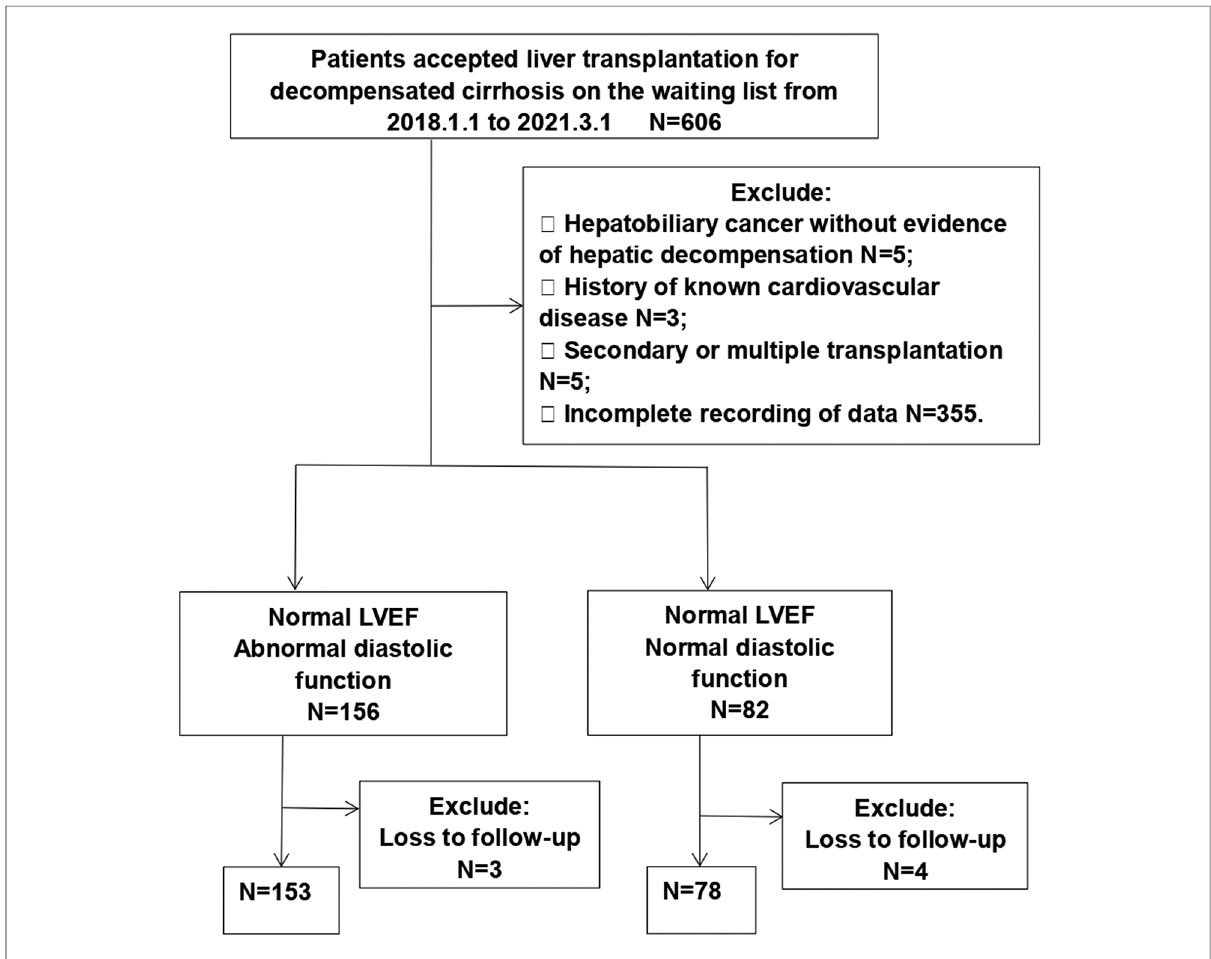
FIGURE 1 Patient fl ow